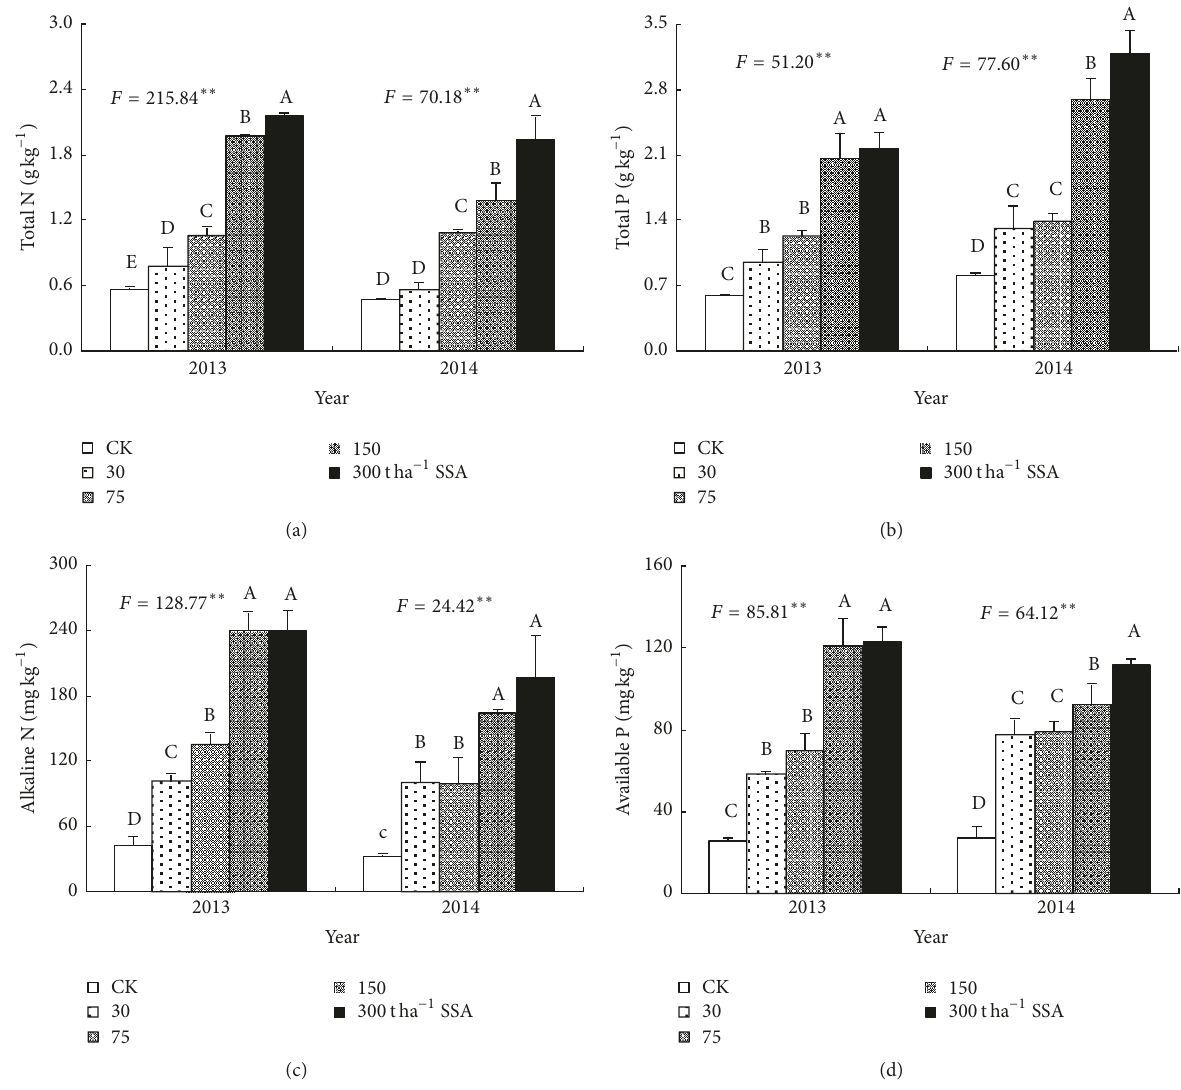
Figure 4: Effects of sewage sludge amendment (SSA) combined with green manuring on the concentration of total N (a), total P (b), alkaline N (c), and available P (d) of coastal mudflat salt-soil. Vertical bars indicate standard deviations of the means. Columns with different letters show significant difference between sewage sludge amendment rates at 𝑝 < 0.05 by LSD’s multiple range test. Values of 𝐹 are the 𝐹 test in ANOVA; ∗∗ 𝑝 < 0.01 . N, nitrogen; P,